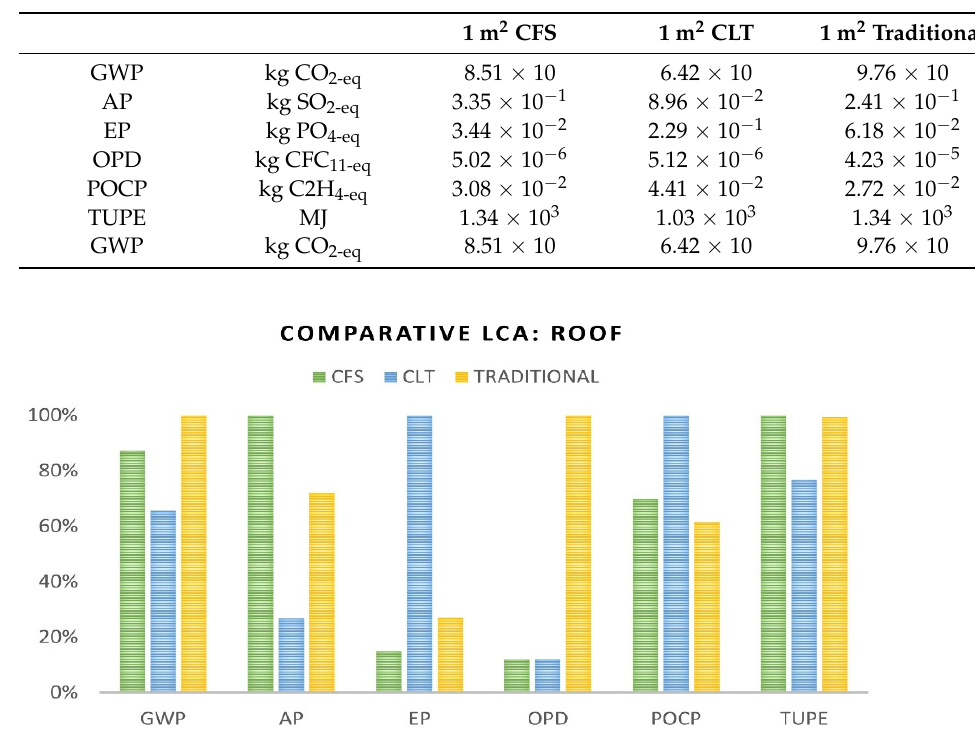
Figure 16. Results of Life Cycle impact assessment: Roof. Table 18. LCA results: roof.